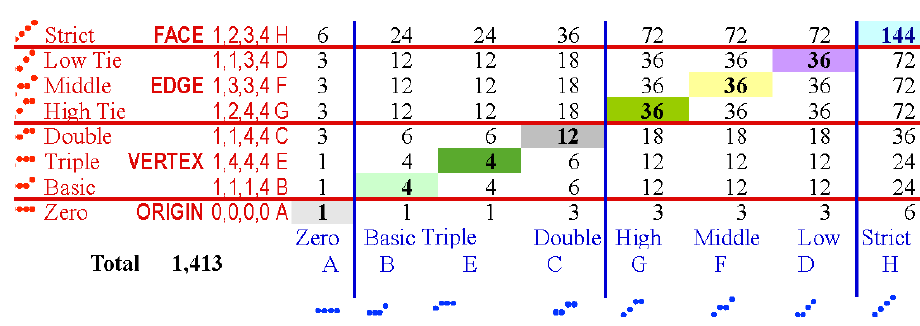
Figure 5. Types of ties categorize the complete set of 2 × 2 ordinal games into eight preference orderings and sixty-four preference classes. Adapted from [13]. For preference orderings A–H see